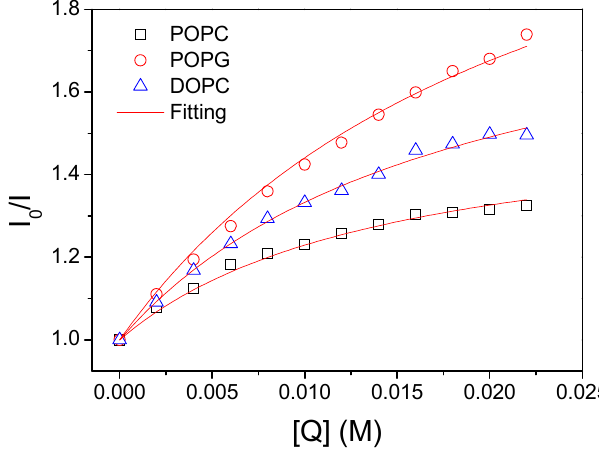
Figure 5. The fluorescence quenching titration data for TAMRA-bR incorporated into three types of lipid vesicles.